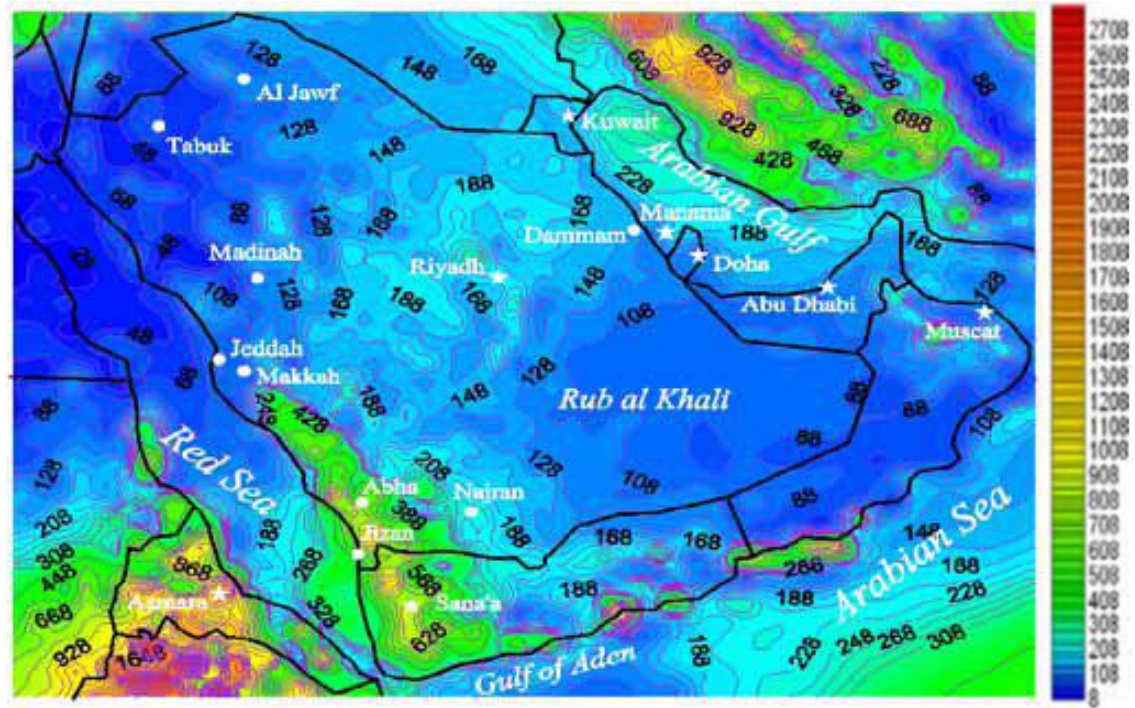
Figure 18. Annual Total Precipitation from the 1972–2001 run